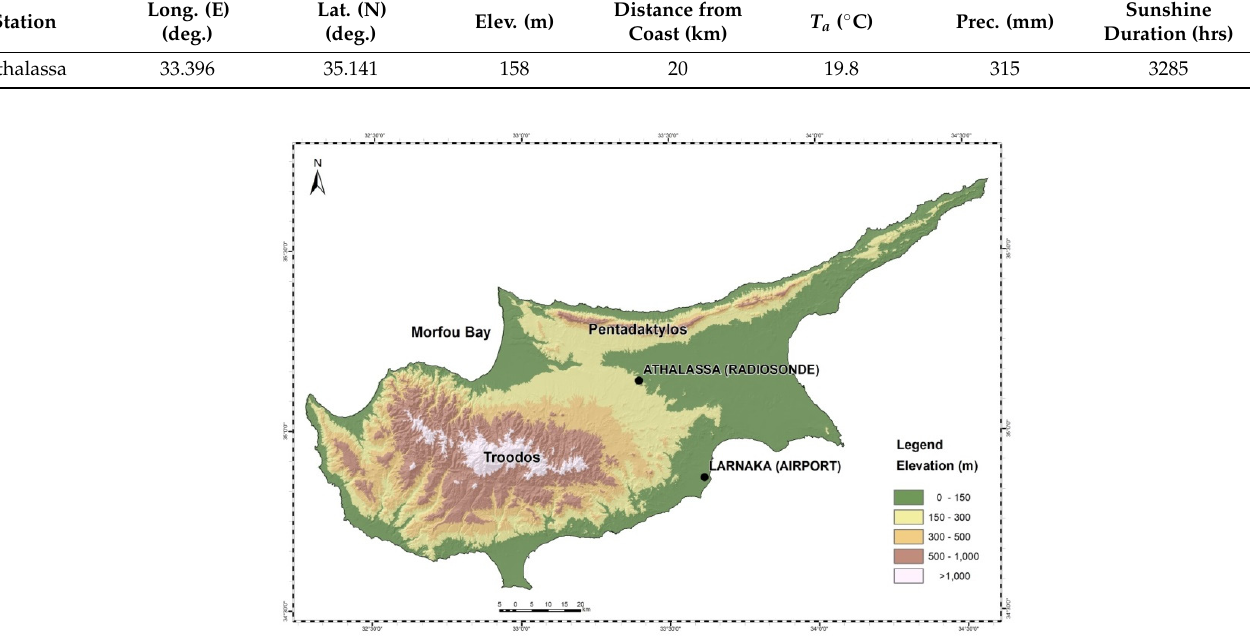
Figure 1. Map of Cyprus showing the location of Athalassa actinometric station.